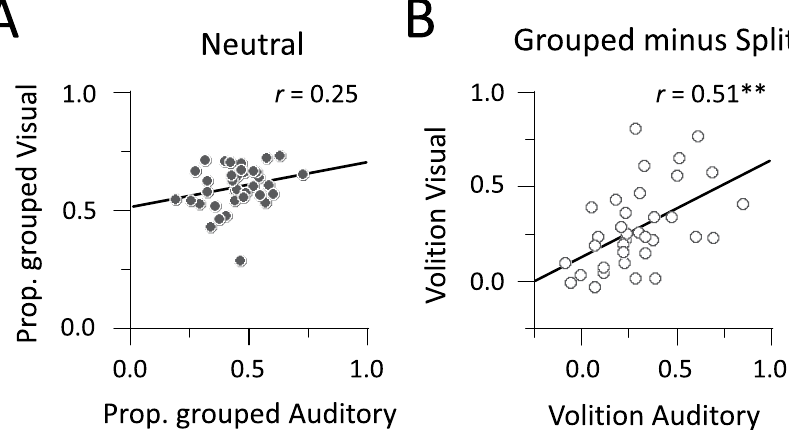
Figure 3. Relationship between perceptual multistability and volitional control. ( A ) Correlation of the proportion of grouped percepts between auditory streaming and moving plaids. Symbols indicate individual data under the Neutral conditions. ( B ) Correlation of the amount of effective volitional control between auditory streaming and moving plaids. The amount of effective volitional control is computed by subtracting the proportion of grouped percepts between the Grouped and Split conditions. ** p <